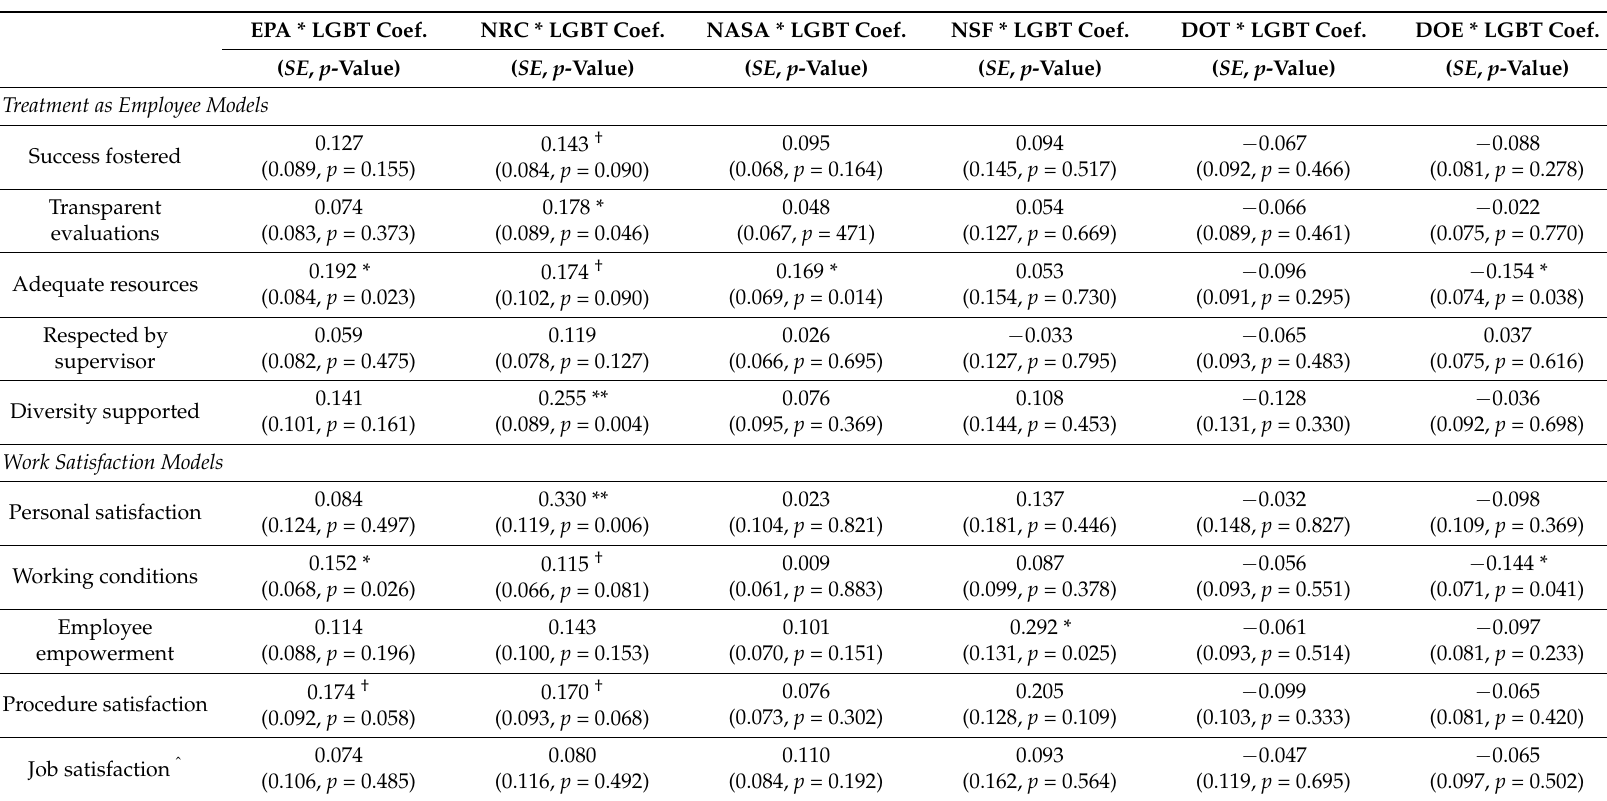
Table A2. Unstandardized Coefficients (with Standard Errors) of LGBT X Agency Interaction Terms from OLS and Ordered Logistic Regression models Predicting Workplace Experience Measures (N =